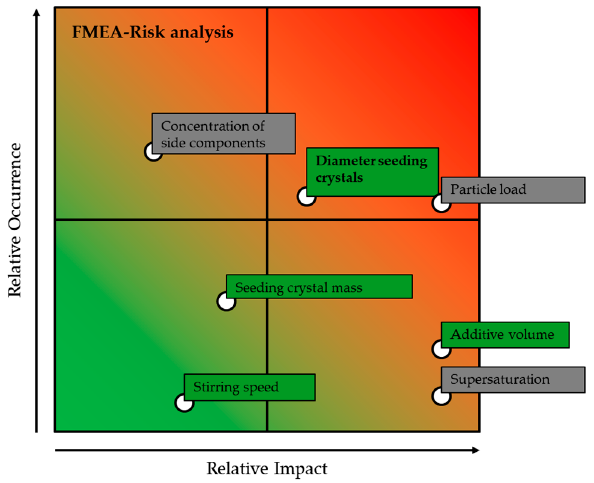
Figure 5. FMEA for the sugar crystallization process.